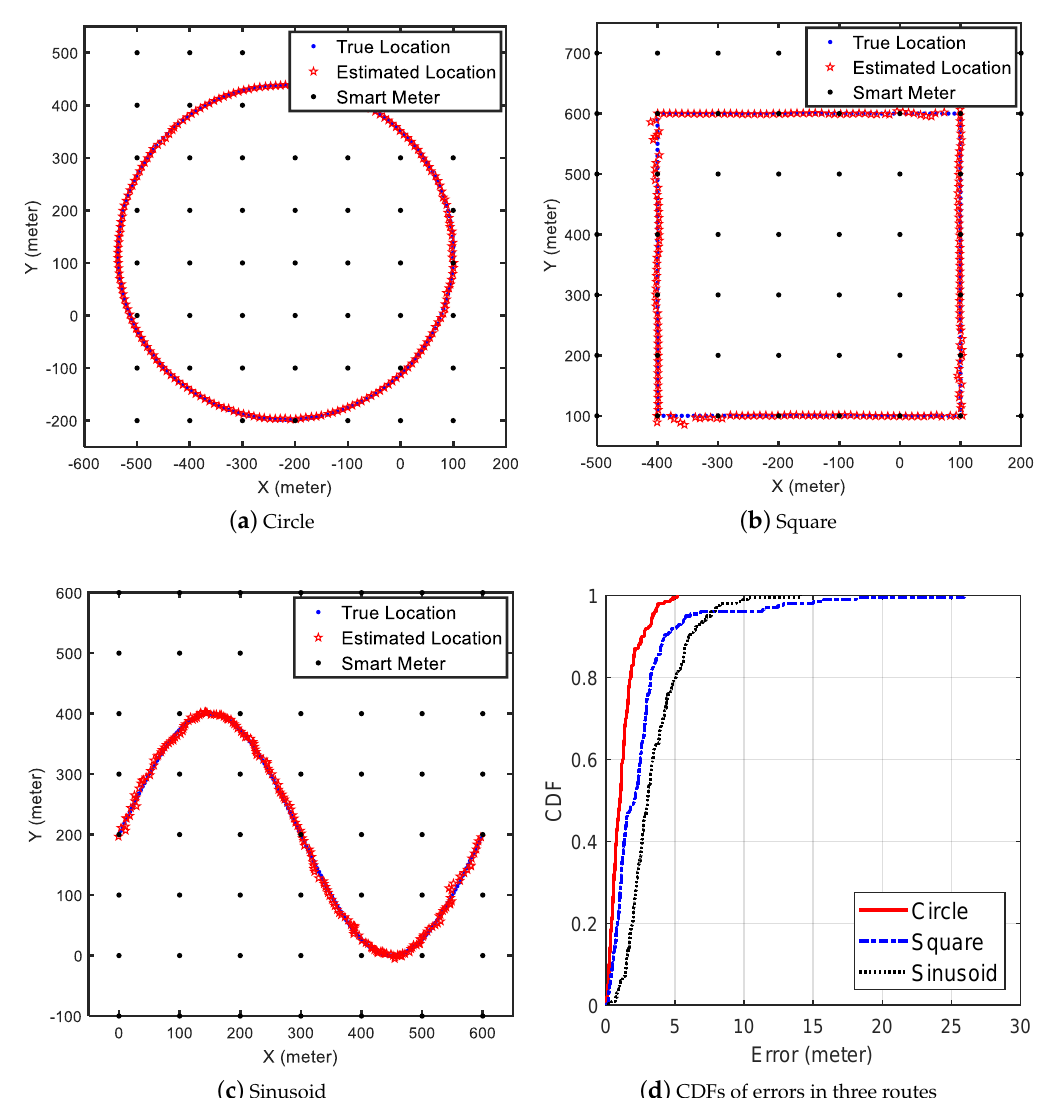
Figure 11. Simulation of three different trajectories the jammer moved